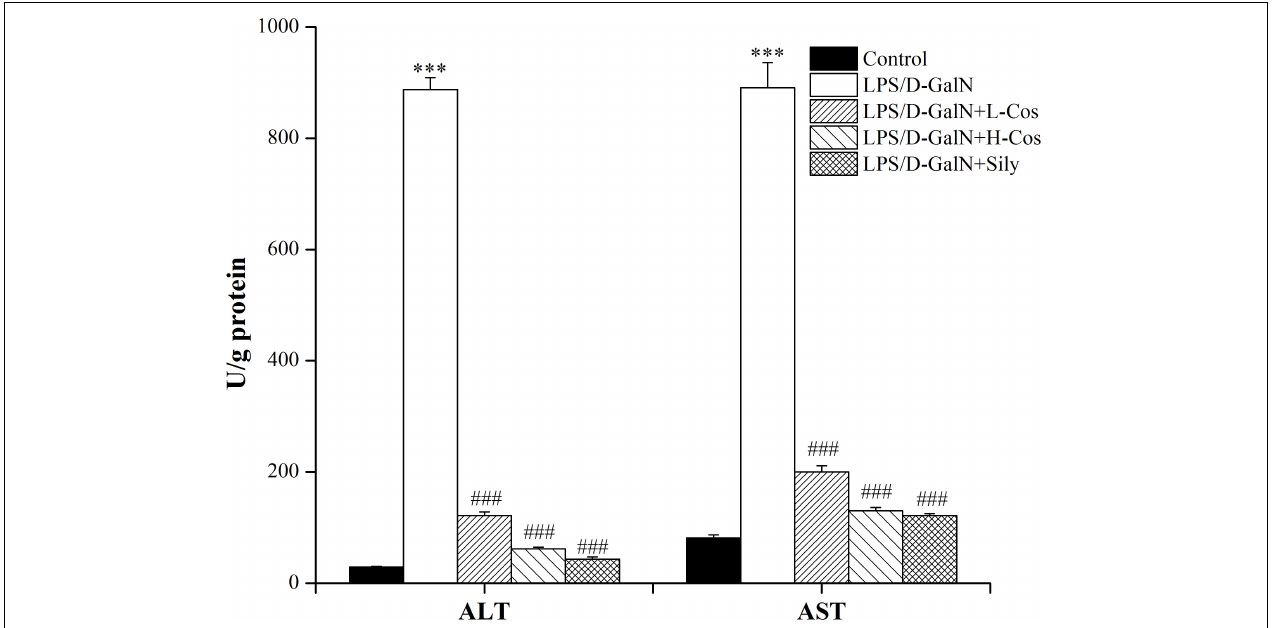
FIGURE 4 | Effects of cos on the activities of AST and ALT induced by LPS/ D -GalN. The data represent the mean ± SD ( n = 10). ∗∗∗ P < 0.001 vs. control group; ### P < 0.001 vs. LPS/ D -GalN group. TABLE 1 | Effects of cos on the activities of hepatic SOD, MDA, CAT, T-AOC, and ROS in LPS/ D -GalN treated mice. Group SOD